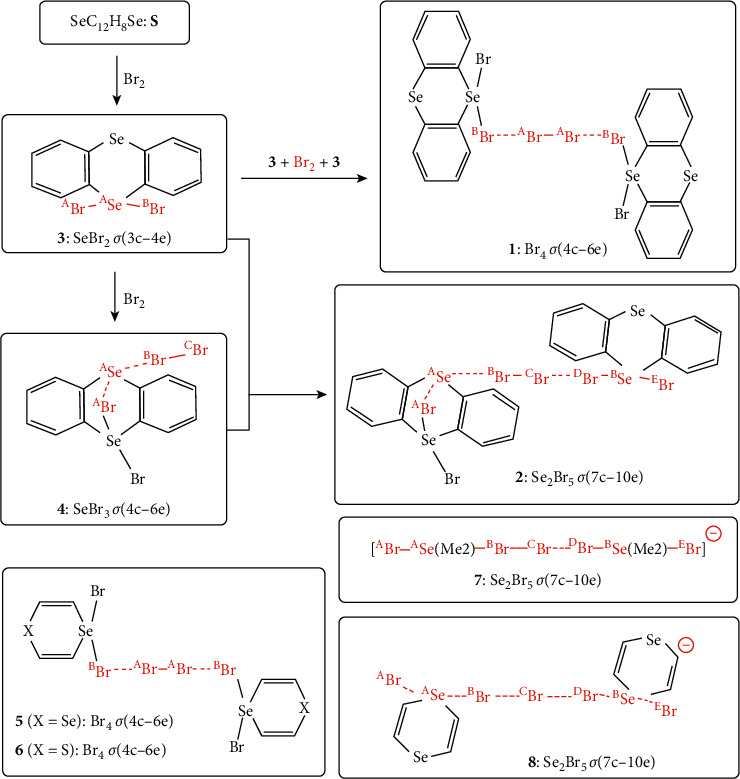
Process assumed for the formation of Br4σ(4c–6e) in 1 from Se(C12H8)Se (S) via 3 and Se2Br5σ(7c–10e) in 2 via 3 and 4. 5 and 6 with Br4σ(4c–6e), models of 1, and 7 and 8 with Se2Br5σ(7c–10e), models of 2, are also shown. Atoms taking part in the linear interactions are shown by red.